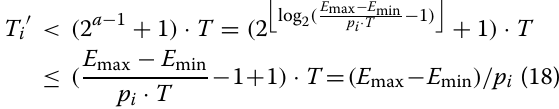
i during the n th and ( n + 1)th charging period. Different